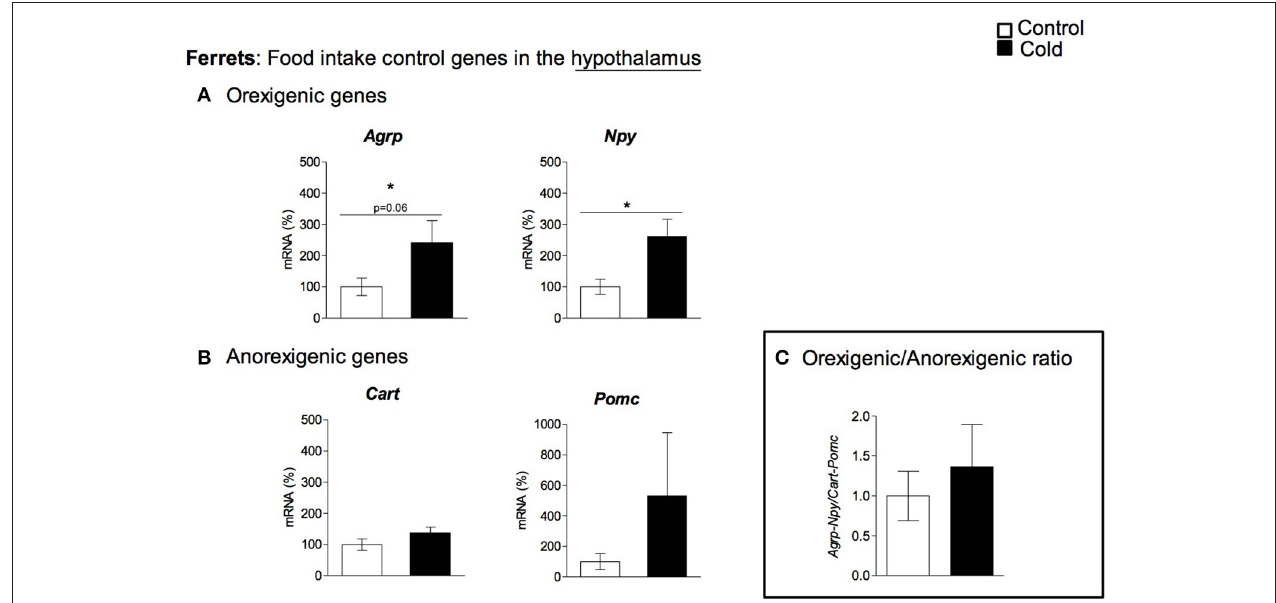
FIGURE 2 | Gene expression of (A) orexigenic ( Agrp and Npy ) and (B) anorexigenic ( Cart and Pomc ) related genes measured by qRT-PCR in hypothalamus of adult ferrets housed at different room temperatures: 22 ◦ C (control) or 4 ◦ C for 1 week (cold). The orexigenic/anorexigenic ratio (C) was calculated as the sum of the expression of the orexigenic peptide ( Agrp and Npy ) genes divided by the sum of the expression of the orexigenic peptide ( Cart and Pomc ) genes. Results represent mean ± SEM ( n = 5–7) of ratios of specific mRNA levels relative to Rgp1, expressed as a percentage of the value of fed animals in the Control group that was set to